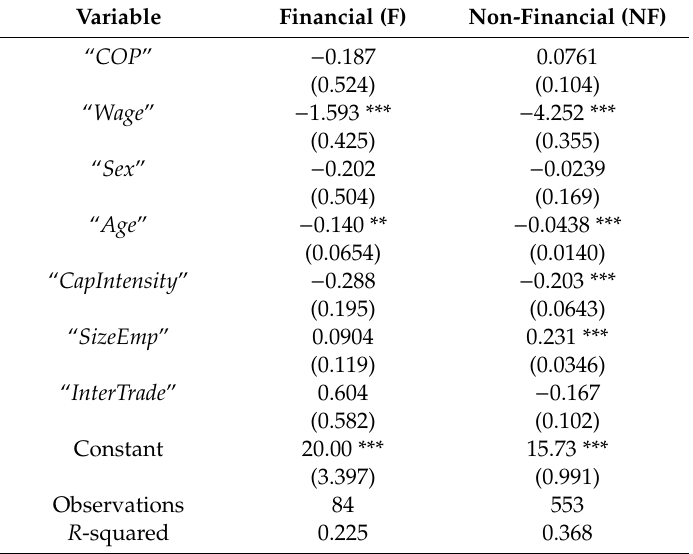
Table 4. Regression results for financial and nonfinancial firms.